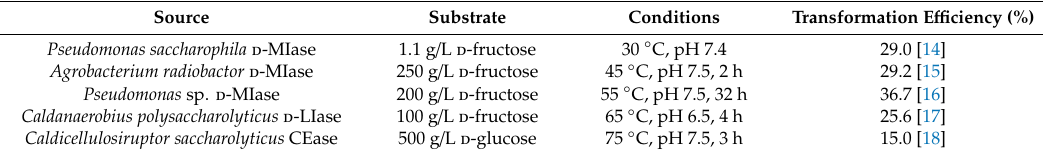
Table 1. Conversion e ffi ciency of enzymes from di ff erent strains catalyzing substrate to d -mannose. Source Substrate Conditions Transformation E ffi ciency (%) Pseudomonas saccharophila d